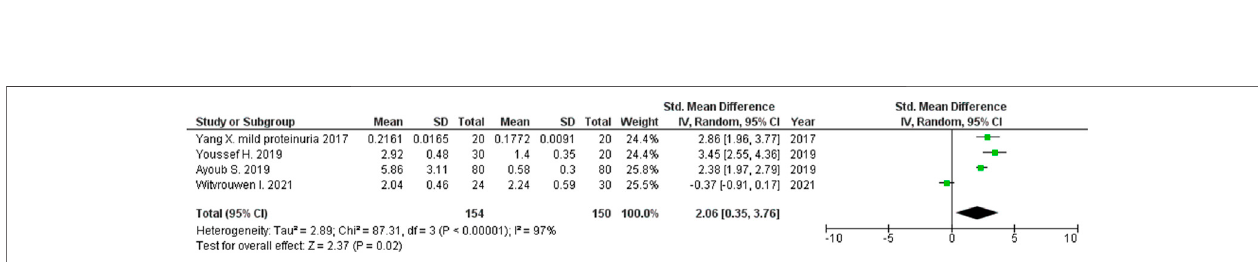
Frontiers in Bioengineering and Biotechnology |